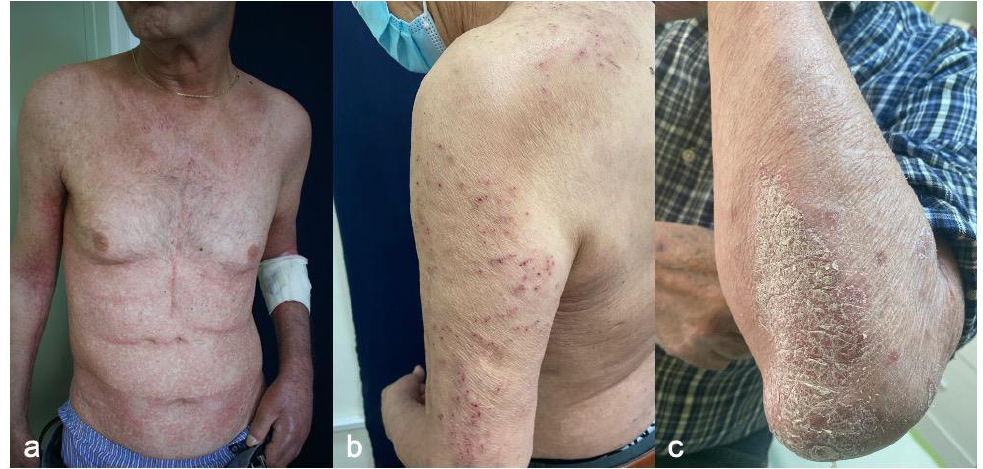
Figure 2. ( a ). Melanoma patient with ICB-induced macular (morbilliform) rash. ( b ). Multiple exco- riations secondary to severe pruritus in a melanoma patient treated with ICB. ( c ). ICB-induced plaque